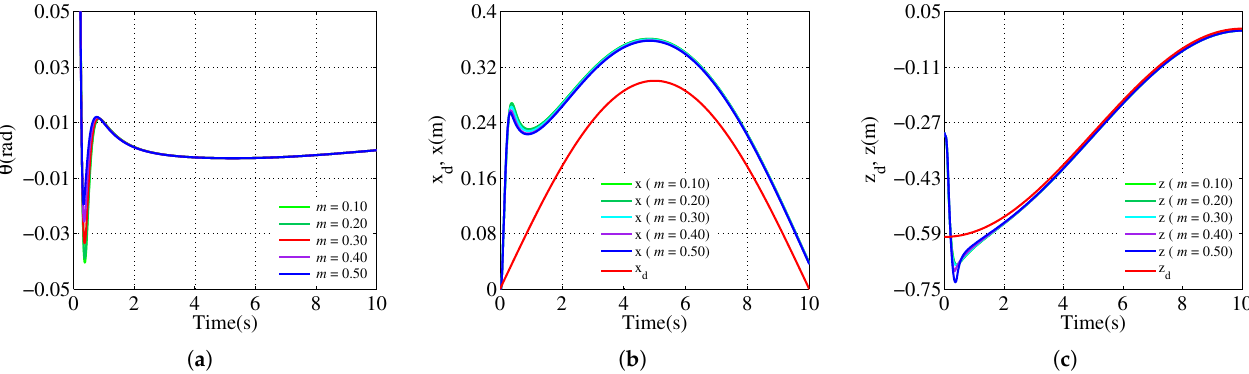
Figure 10. The simulation tests when m = 0.10,0.20,0.30,0.40, and 0.50. ( a ) The θ ; ( b ) the x d and x ; and ( c ) the z d and z .